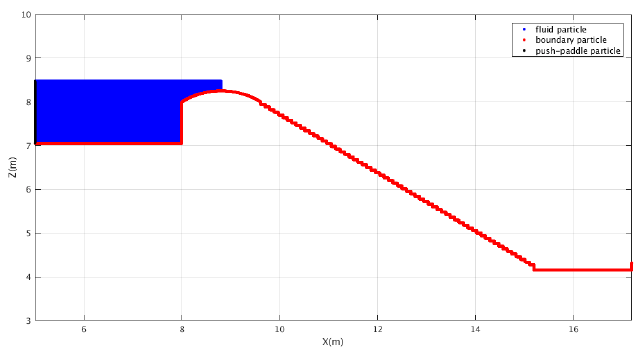
Figure 6. SPH computational domain of stepped spillway flow.